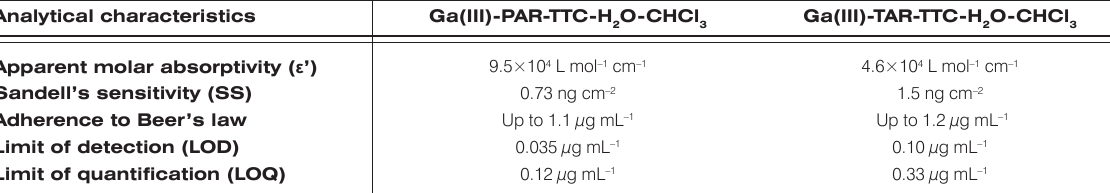
Table 6. Characteristics concerning the application of the ternary complexes for extractive-spectrophotometric determination of gallium(III). Analytical